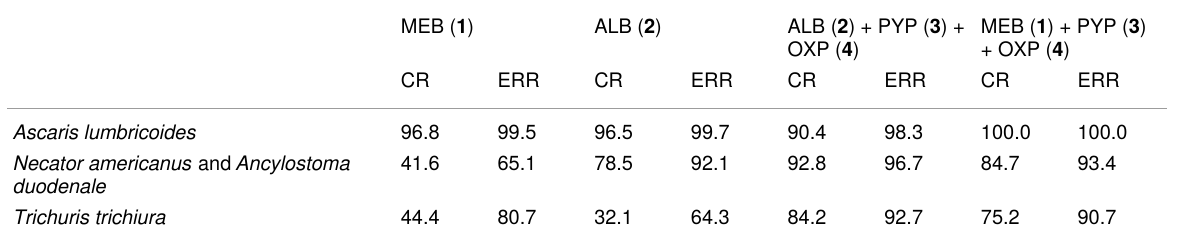
Table 2: Drug combinations show increased single-dose cure rates for soil-transmitted helminths. CR: cure rate – the proportion of infected individ- uals who become negative when tested after treatment with the indicated drug(s). ERR: egg reduction rate – the reduction in egg count after treat- ment expressed as a proportion of the egg count before treatment. Data from